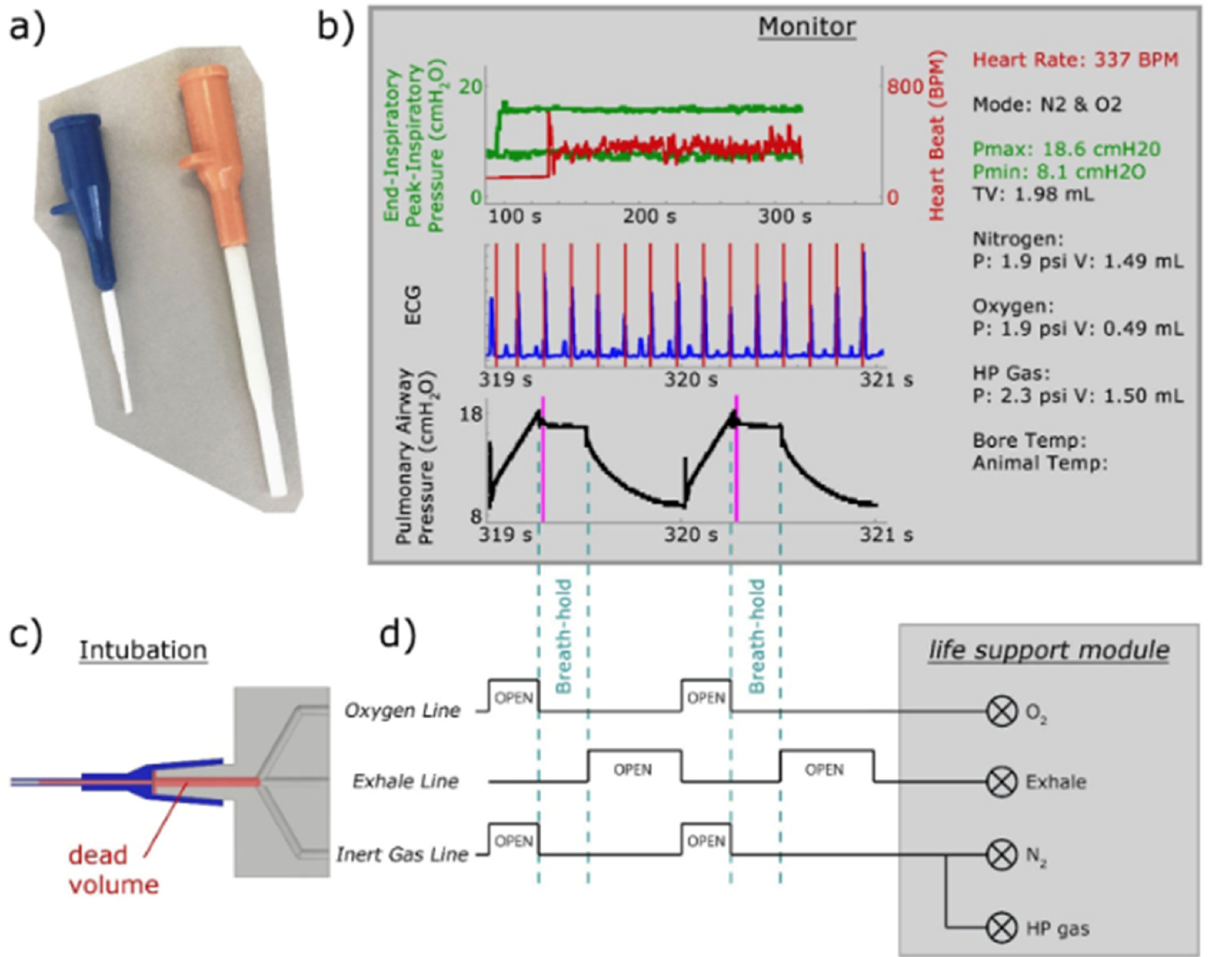
Figure 35. ( a ) Tapered intubation catheters for mice (22 G, blue) and rats (14 G, orange). ( b ) Display of the ventilator while ventilating a rat, showing real-time airway pressure (black), the MR trigger (pink), ECG (blue) with automatic r-wave detection. The evolution of the peak inspiratory and expiratory pressures (green), and heart rate (red) over the duration of the study are also shown. The top right corner of the display shows the current heart rate, ventilation mode, airway pressures, gas-delivery pressures and associated tidal volumes. ( c ) Cross-sectional view of the intubation catheter connected to the mouthpiece, showing the merging gas lines, and the dead volume. ( d ) Actuation pattern of the gas delivery valves (drawn in synchrony with the airway pressure trace on the monitor). Reprinted with permission from Virgincar, et al. ( J Magn Reson 2018, ref.